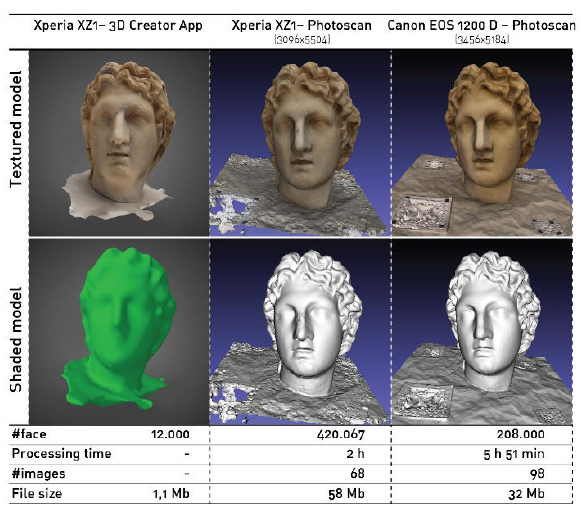
Figure 9. Comparative assessment-matrix on Siceliota Lekane cover